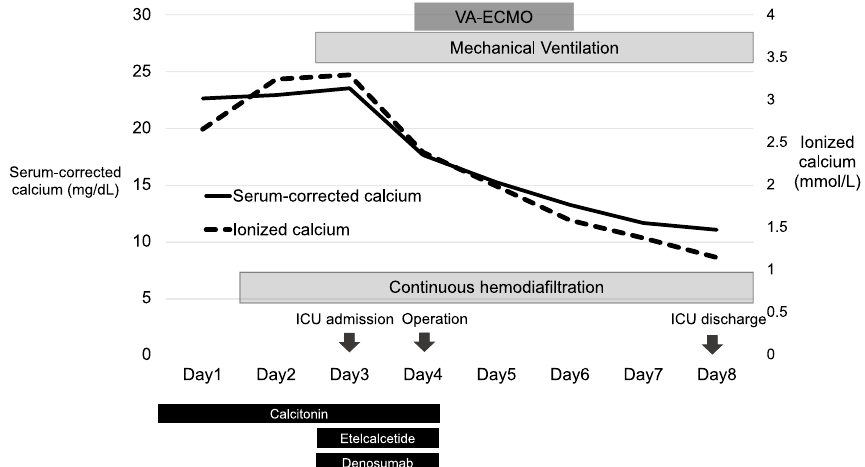
Fig. 3 Clinical course, corrected, and ionized serum calcium concentrations. Serum-corrected calcium concentration (mg/dL) concentration (mg/dL) 4-albumin +